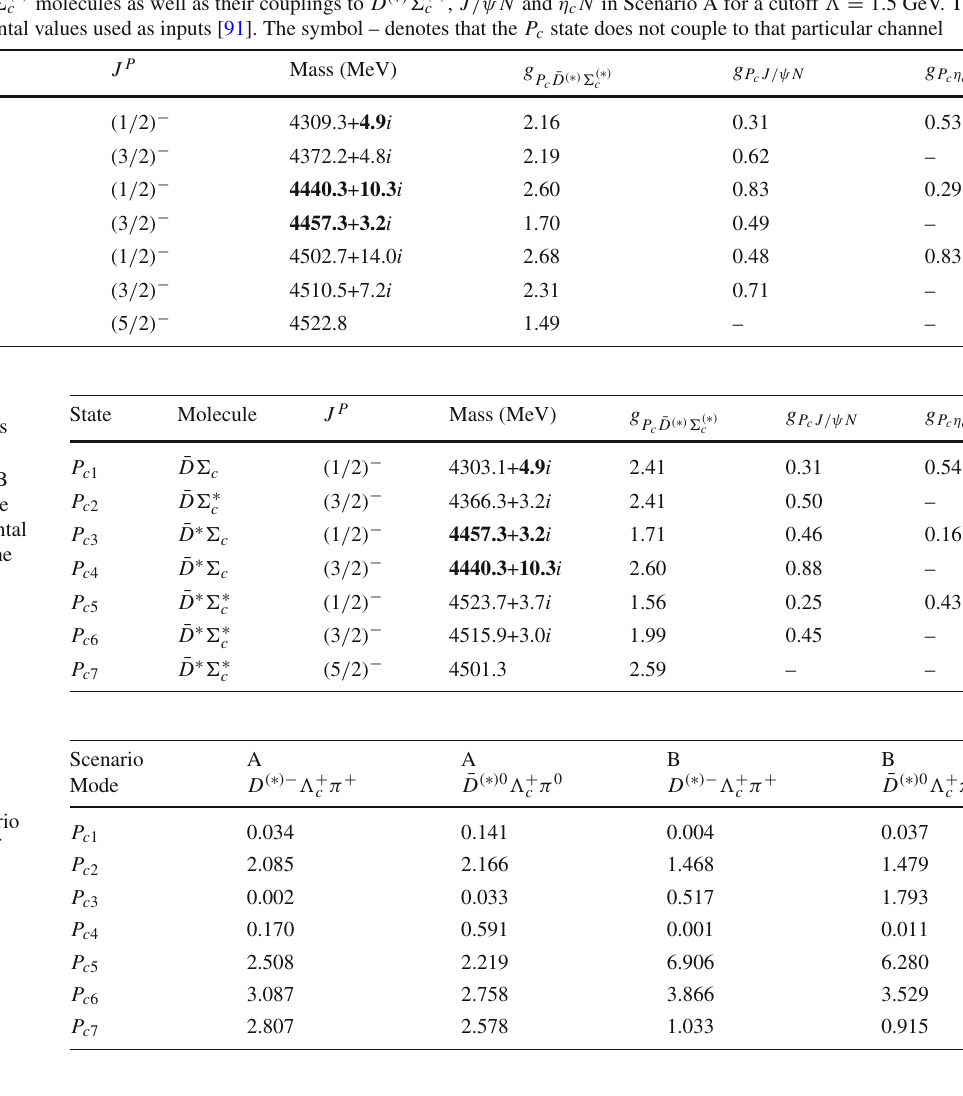
Table 3 Masses of the ¯ D ( ∗ ) (cid:2) ( ∗ ) c molecules as well as their couplings to ¯ D ( ∗ ) (cid:2) ( ∗ ) c , J /ψ N and η c N in Scenario A for a cutoff (cid:4) = 1 . 5 GeV. The bold figures are the experimental values used as inputs [91]. The symbol – denotes that the P c state does not couple to that particular channel